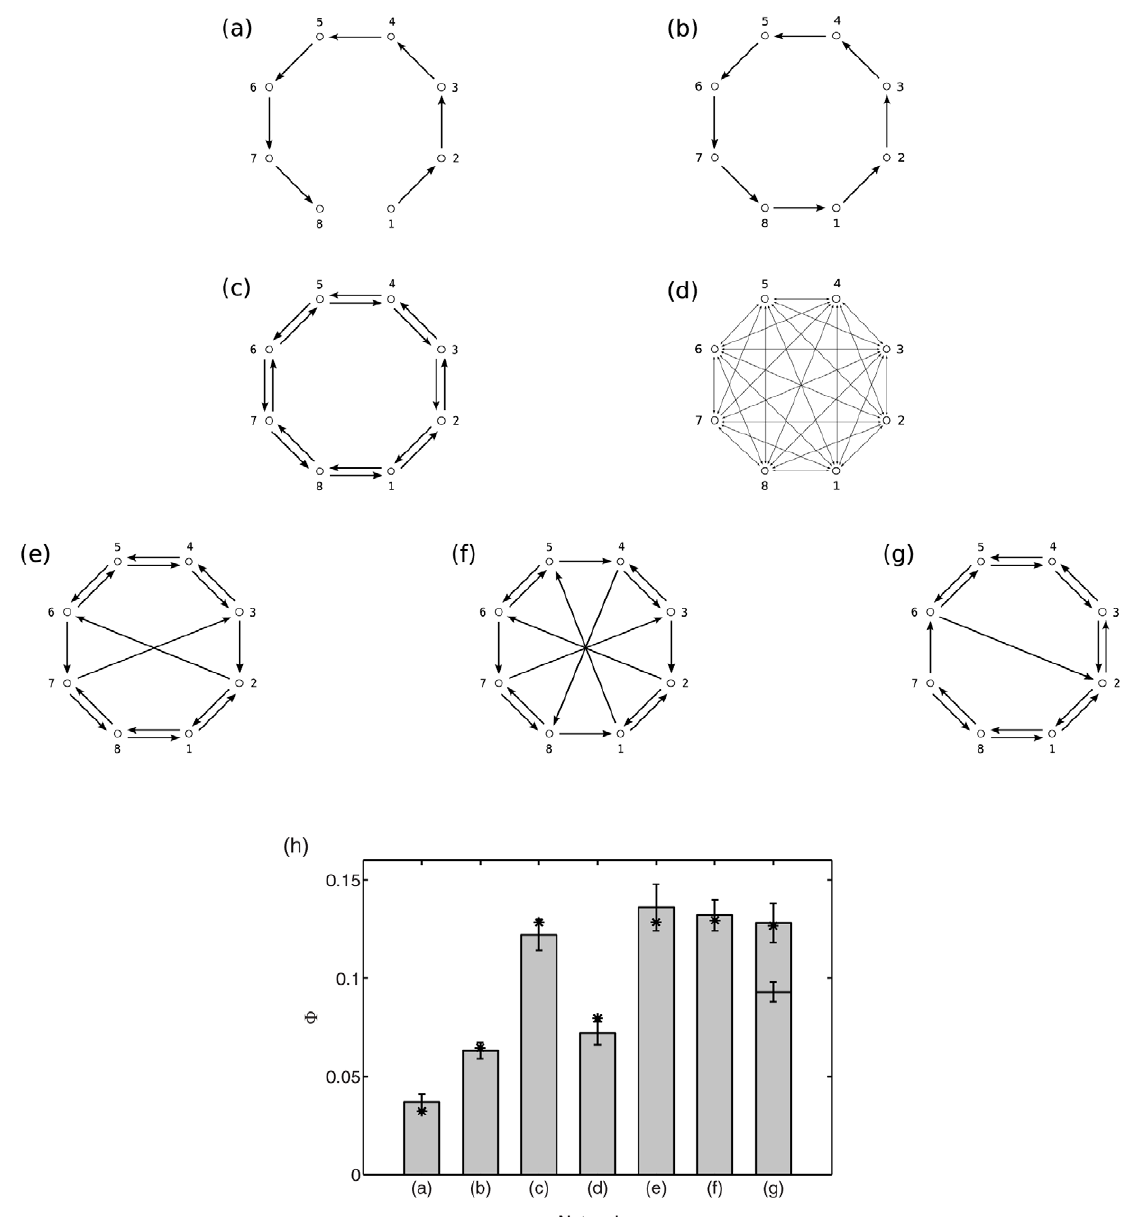
Figure 1. Integrated information in Markovian Gaussian systems. (a)–(g) Connectivity diagrams for seven systems as specified by the corresponding connectivity matrices A . Arrow widths reflect connection strengths: for (a)–(c) and (e)–(g), all connection strengths are 0.25; for system (d) each connection strength is 1/14, thus the total afferent connection to each element is 0.5. (h) Integrated information, as measured by W E ( t ~ 1 ) for each of the systems (a)–(g), via simulated data (bars) and analytically via the generative model (asterisks). For simulated data, 10 trials were performed, with each trial generating 3000 data points. Bars show mean values; error bars show plus/minus one standard deviation. For system 1(g), sizes of sub-systems in the MIB varied across trials, falling into two distinct groups which are shown separately (the top bar reflects a group of 6 trials; the bottom bar, 4 trials).